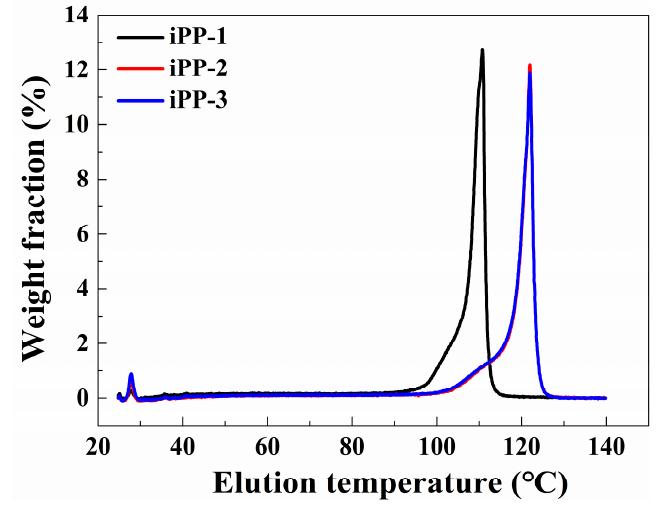
Figure 4. Temperature rising elution fractionation (TREF)curves of the iPP samples. Table 3. Data of TREF test.